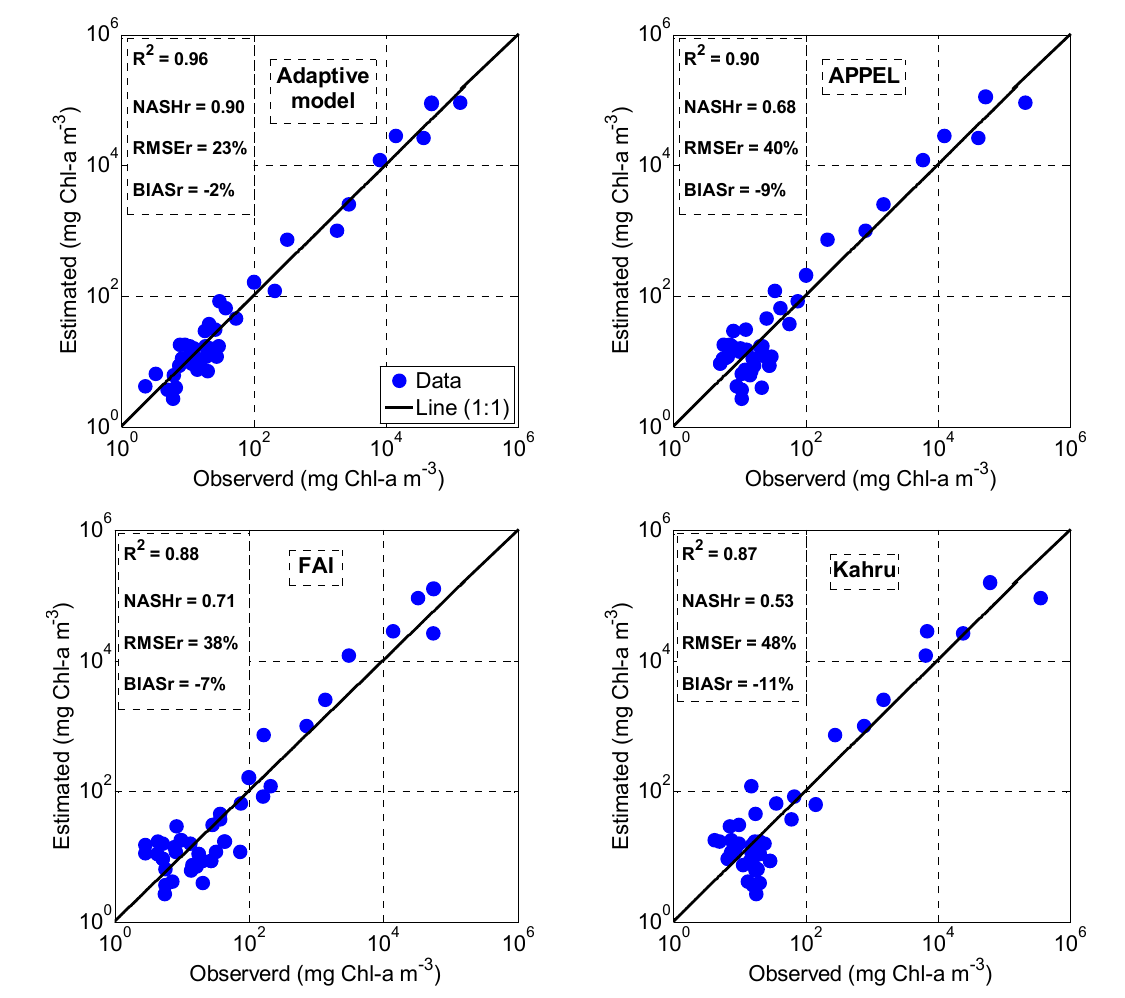
Figure 9. Chlorophyll-a concentration estimated from the four models compared to in situ measurements for the complete database, with model performance indices.